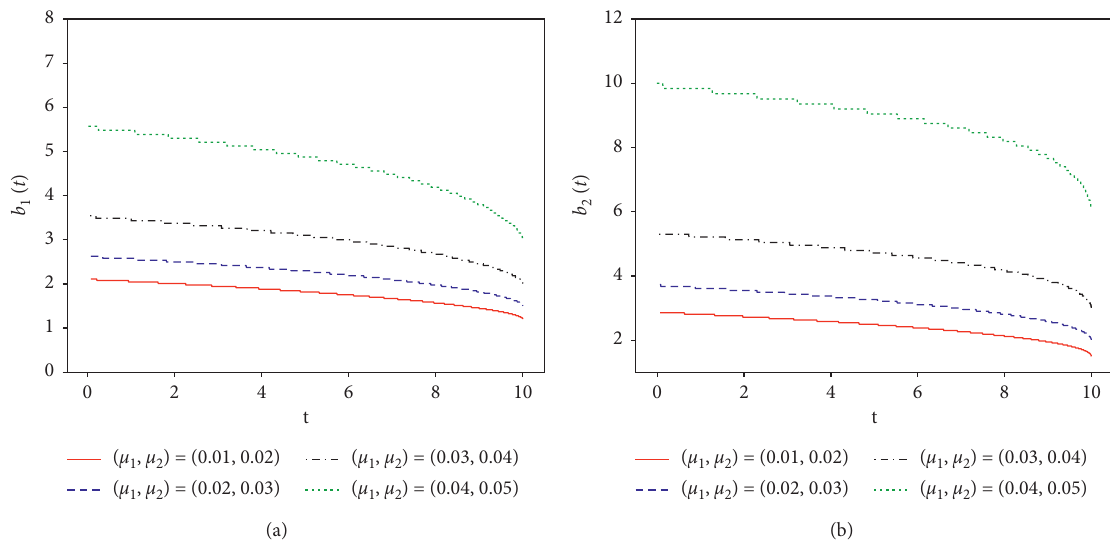
Figure 4: The impact of varying return rate of stock on the early exercise boundary for (A.) regime 1 and (B.) regime 2.